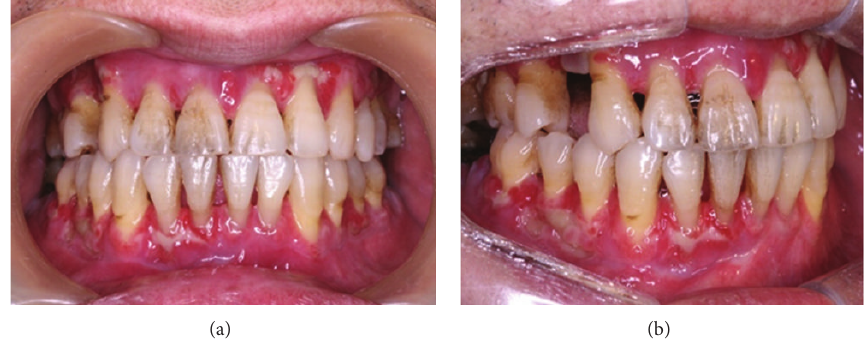
Figure 3: An apparent improvement, with a decreased swelling and necrotic tissue, is observed after a two-week antifungal therapy.